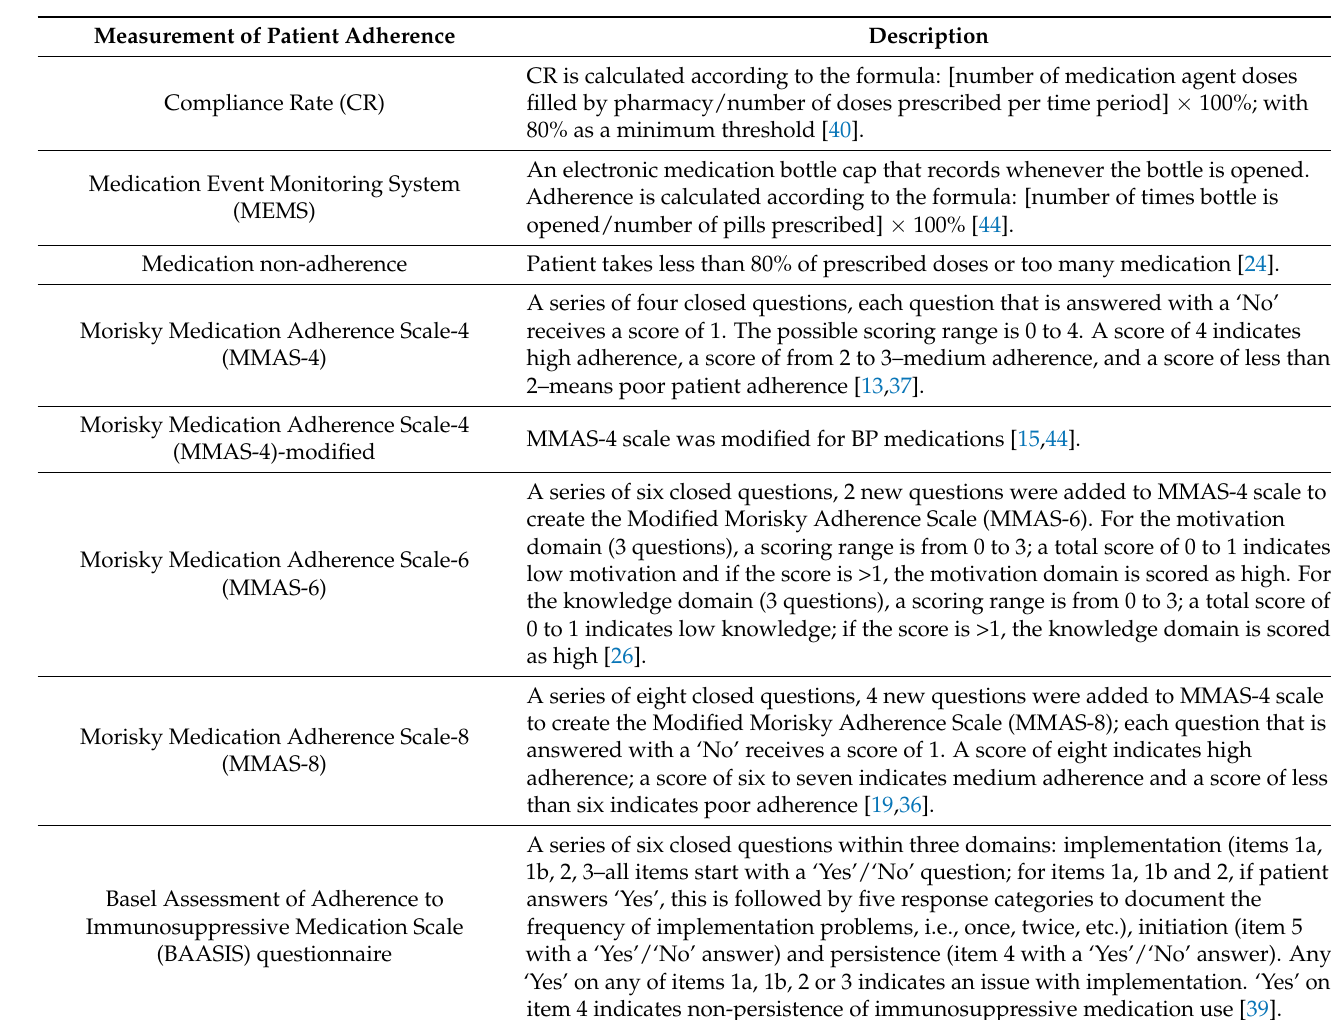
Table 2. Adherence measurement according to the reviewed